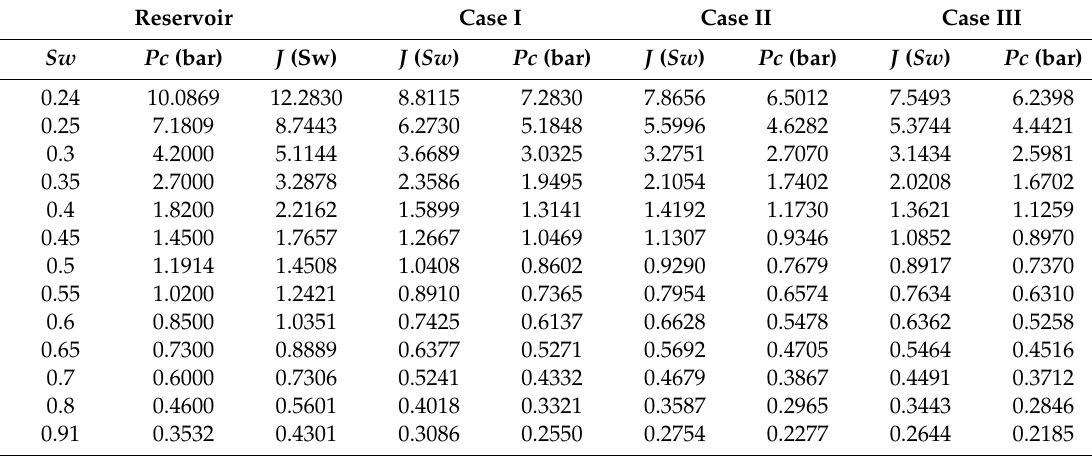
Table 4. Capillary pressure data for all